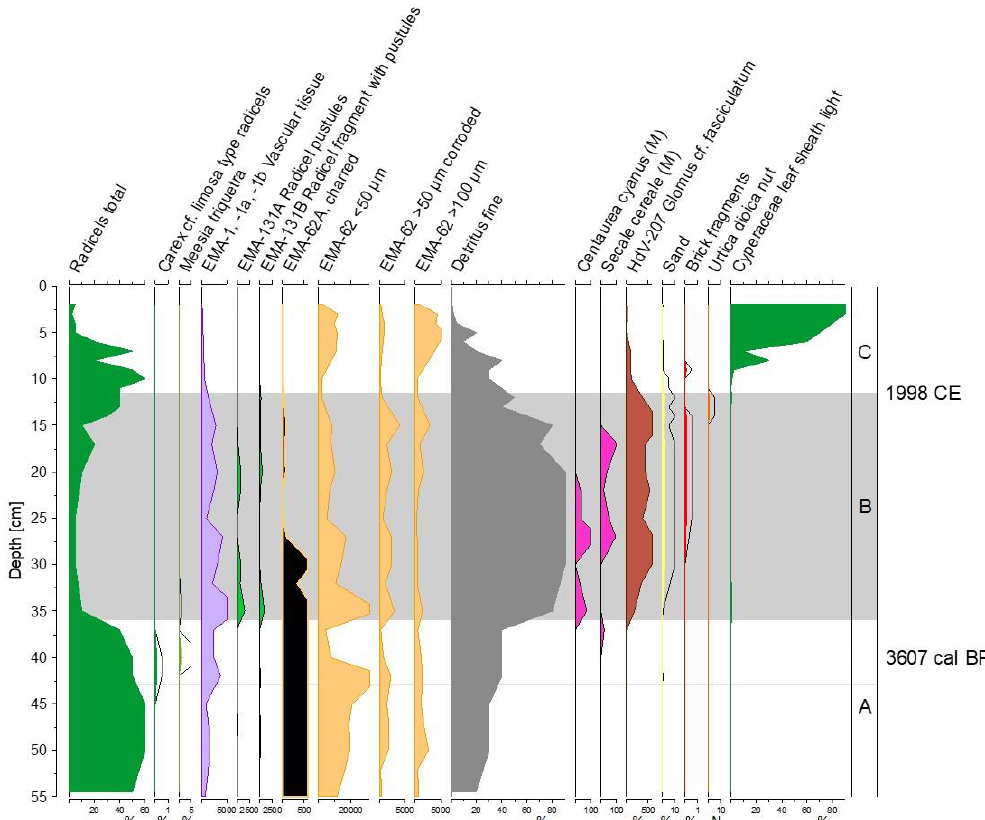
Figure 2. Selected curves of macro- and micro-remain analyses of site PW. Note the scales and units of the x-axes. Curves show percentages (%) or number (N) of macro-remains as indicated or otherwise concentrations (10 1 N cm −3 ) of micro-remains.